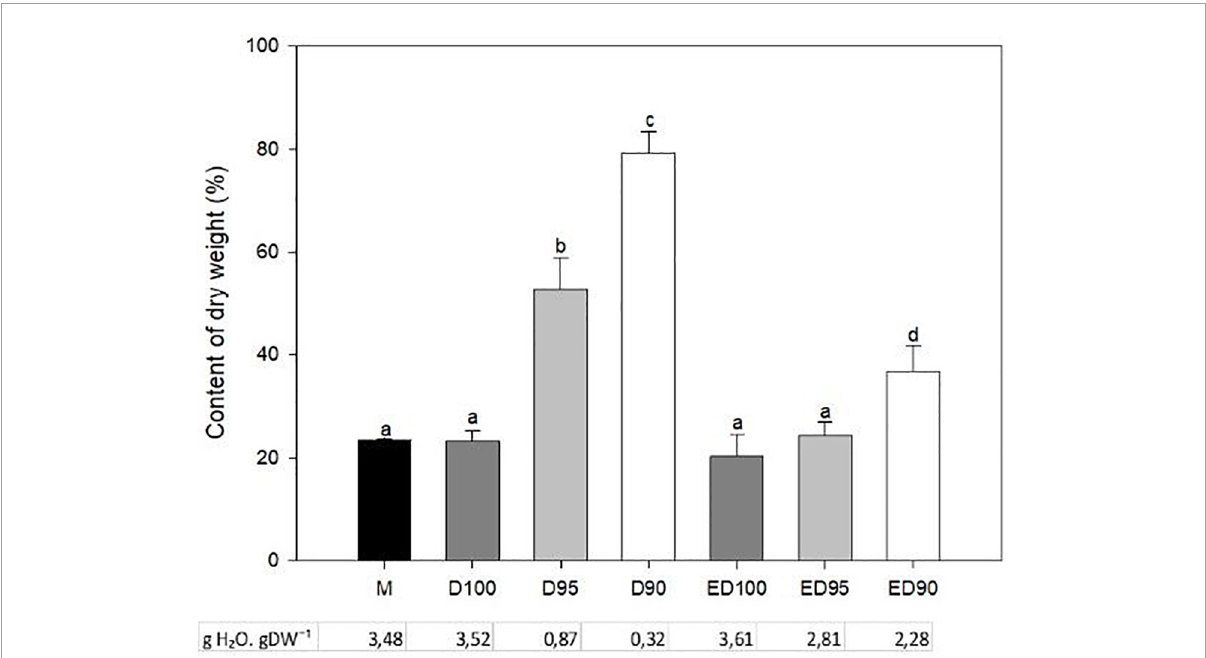
FIGURE4 The effect of desiccation on the dry weight and water content of mature embryos (M), control embryos at half (D100), and at the end (ED100) of treatment with 100% relative humidity, and embryos exposed to relative humidity of 95 and 90% during the first half of desiccation (D95 and D90) and subsequently transferred to 100% relative humidity (ED95 and ED90). Values are given as means ± standard deviations of four independent experiments ( n = 8). Different letters indicate a statistically significant difference at p ≤ 0.05.